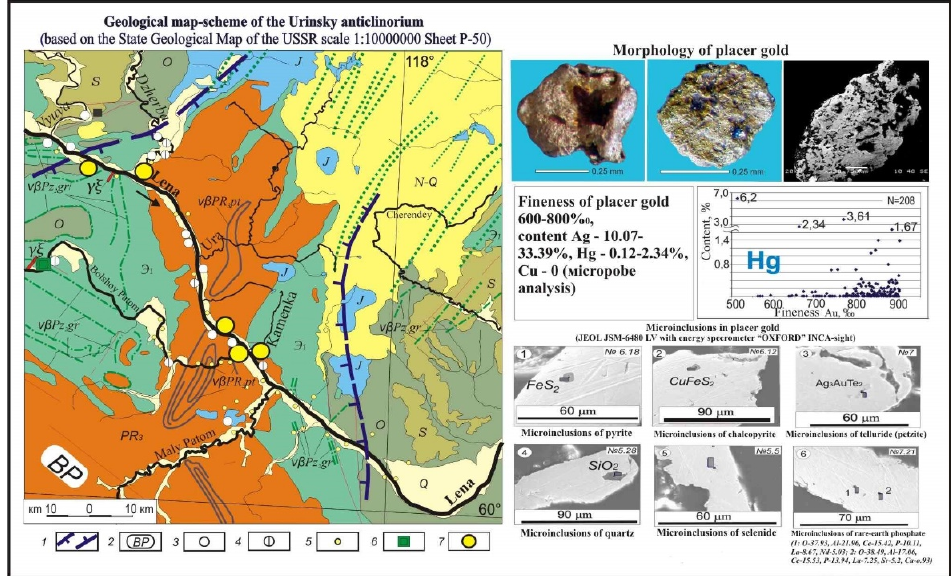
Figure 5. Mineralogical and geochemical features of placer gold of the mouth of B. Patom. 1— boundaries of the Urinsky anticlinorium; 2—Baikal-Patom fold-thrust belt; 3–5—the content of placer gold in placer occurrences: 3—100–200 mg/m 3 ; 4—50–100 mg/m 3 ; 5—minimal < 50 mg/m 3 ; 6—ore occurrence; 7—places of heavy mineral sampling of placer gold.